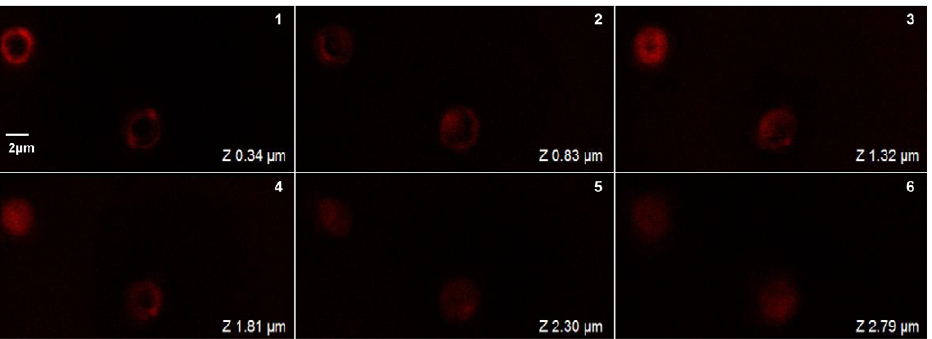
Figure 3. Localization of AF-SWCNTs in side erythrocytes by confocal microscopy. Fluorescenated AF-SWCNTs were prepared as described in Materials and Methods. Erythrocytes were incubated in RPMI + 1%FBS with 50 m g/ml fluorescenated AF-SWCNTs for 1 h and unbound/loosely attached particles were removed by three extensive washings with PBS. After that erythrocyte suspension was taken for confocal microscopy. Above figure shows fluorescence images of erythrocytes incubated with alexa fluor 633 hydrazide tagged AF-SWCNTs as z-sections. (Magnification 100X).